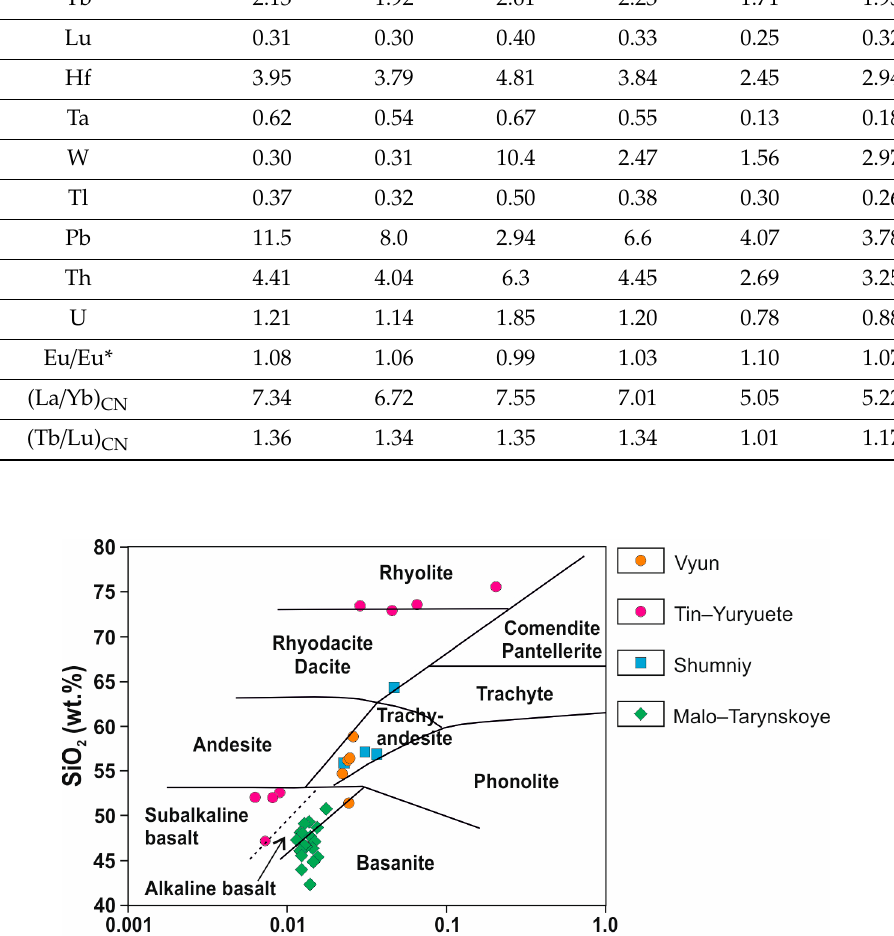
Figure 6. REE diagram ( A ) and spider diagram ( B ) for the studied igneous rocks. Chondrite and primitive mantle normalizing values were from [62]. Blue and grey fields—concentrations for Grenada Island (Lesser Antilles island arc) basalts with, respectively, a peridotite–pyroxenite source (5% mantle wedge melting) and a mainly peridotite source (25% Mg-enriched mantle wedge melting) [63]. Concentrations from the Ergelyakh pluton granite–porphyry and granodiorite–porphyry were from [13].